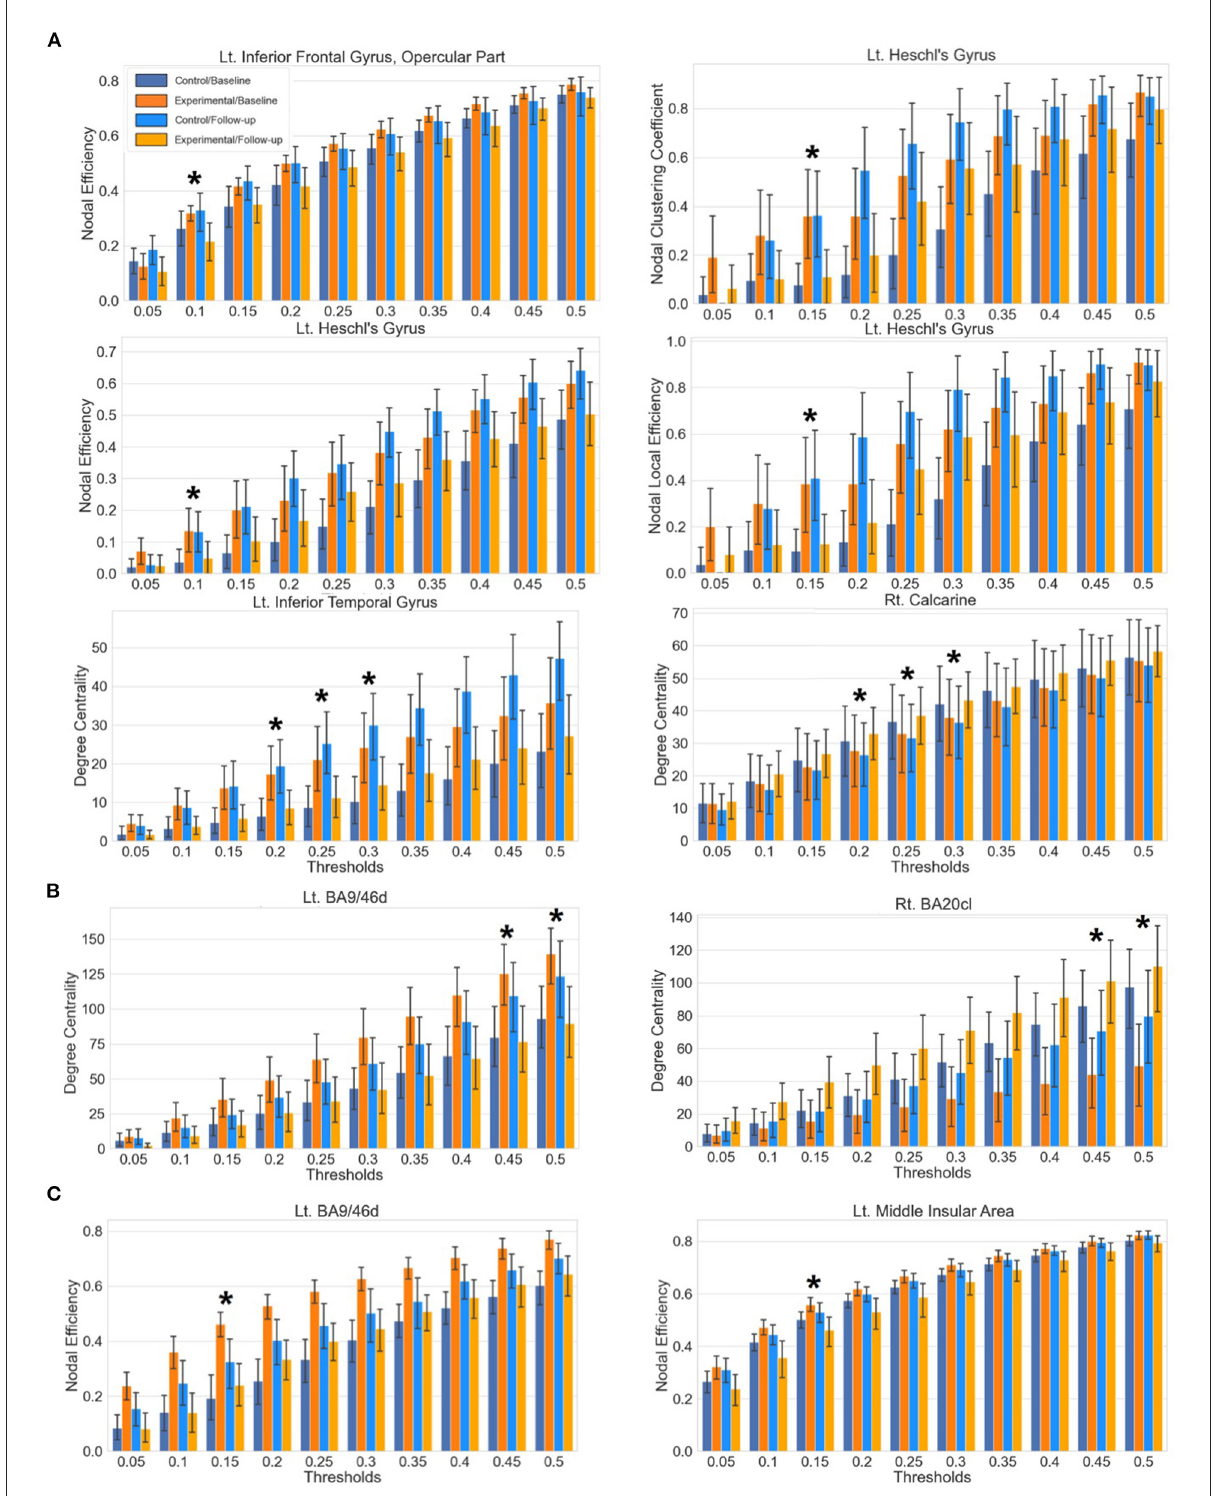
FIGURE4 Bar plots of the local network metrics at baseline and follow-up with respect to varying thresholds. Statistically significant results after the correction of multiple comparisons are indicated with an asterisk. Each whisker indicates the 95% confidence interval. (A) Results from the AAL atlas. (B) Results from the Brainnetome atlas. (C) Results from the Glasser